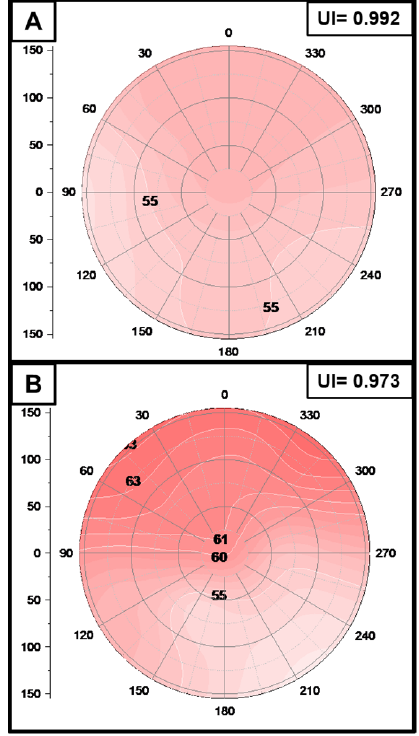
Figure 8. Experimental results of ammonia uniformity in the catalyst inlet: ( A ) L-type urea injector and ( B ) I-type urea injector.